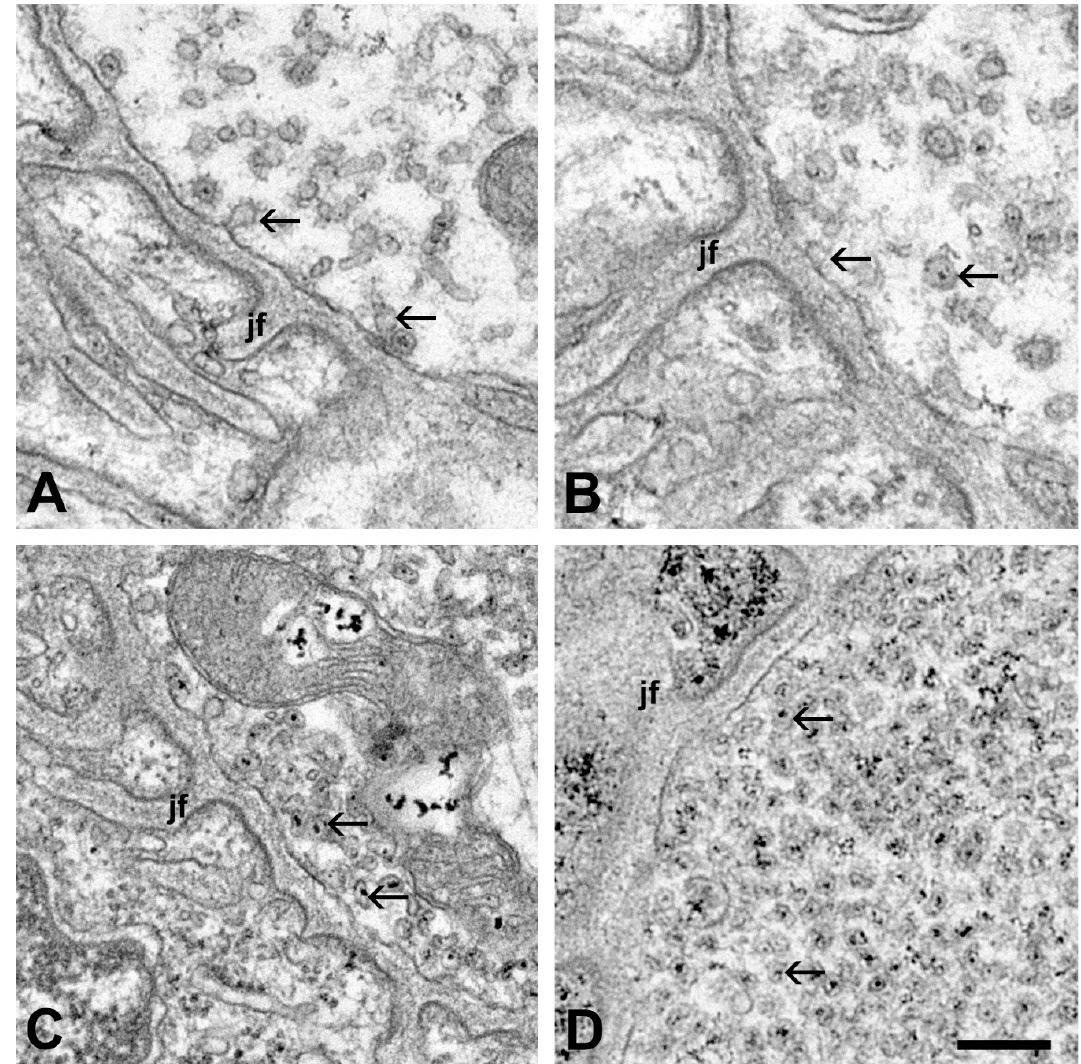
Figure 3. Enlarged view of motor axon terminals in the vicinity of the active zones of the neuromuscular synapses—oxalate-pyroantimonate fixation. In the axon terminal of an untreated mouse ( A ), and a mouse injected with serum from a healthy individual ( B ), only a few synaptic vesicles (arrows) are present. Some of them contain dot-like electron-dense deposits (EDDs). Axon terminals from mice injected with serum from ALS patients, represented with superoxide dismutase 1 (SOD1) pAsp90Ala ( C ) and chromosome 9 open reading frame 72 (C9ORF72) mutations ( D ), display an increased number of synaptic vesicles in these regions. The increase in the number of synaptic vesicles is exceptionally high in the axon terminal of a mouse injected with the sera from a patient with a C9ORF72 mutation ( D ). jf: junctional folds. Scale bar: 200 nm.